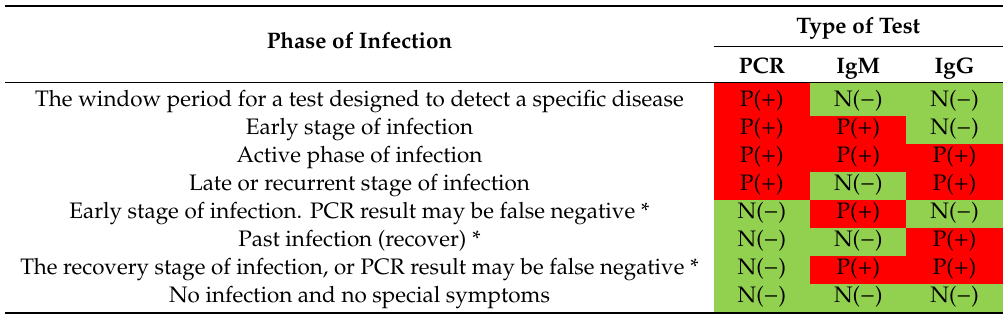
Table 5. Clinical significance of an IgM / IgG serological test